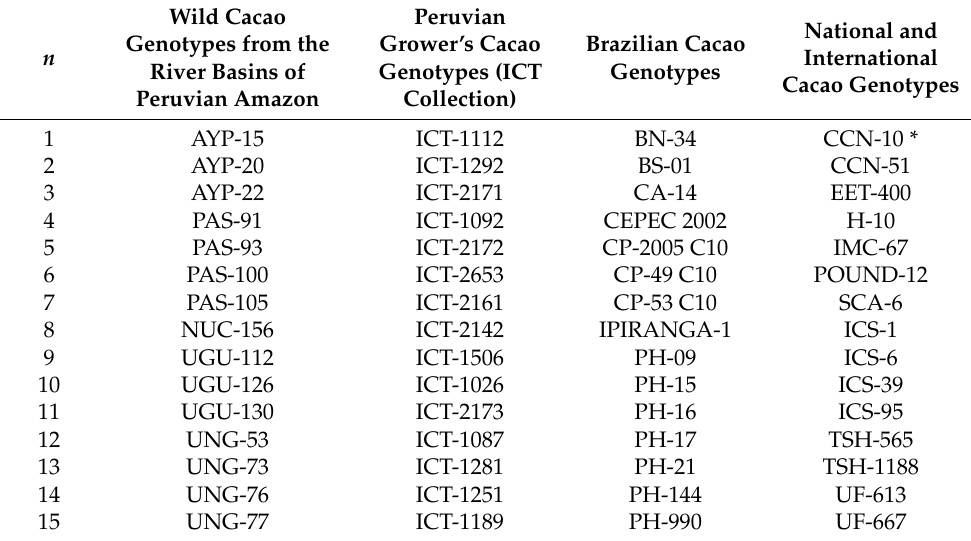
Figure 1. Location of Instituto de Cultivos Tropicales facilities in La Banda del Shilcayo district, adjacent to the main city of Tarapoto in the San Martin region, Peru. Cacao genotypes explored for this study were obtained from the ICT germplasm bank ubicated in the El Choclino Experimental Station. In total, 60 cacao genotypes from four geographic regions were selected and the list is presented in Table 1. Table 1. List of cacao genotypes ( n = 60) from four different geographical origin used for the experiment with soil acidity tolerance.